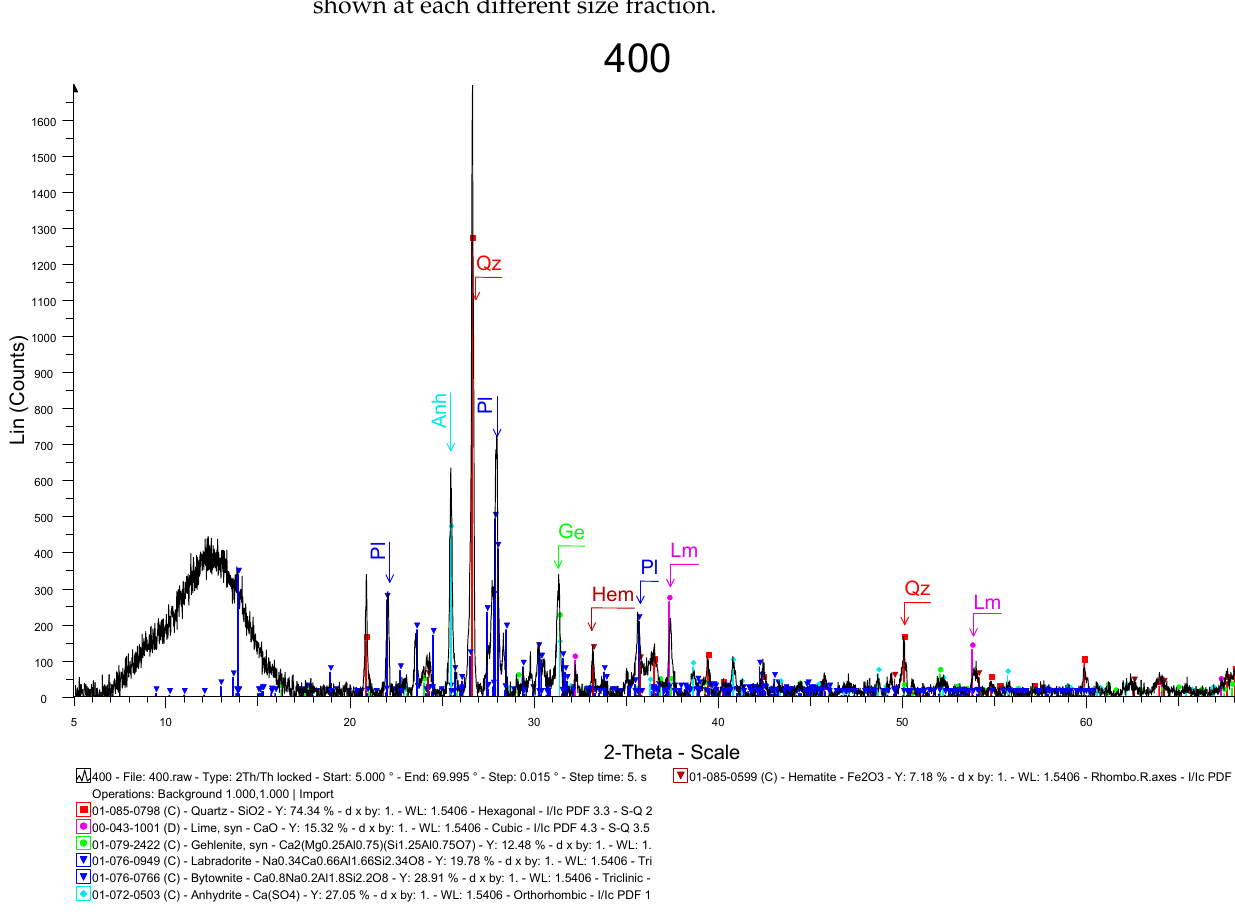
Figure 2. XRD Analysis for the -400 Mesh size fraction. Table 1. Chemical composition of the initial samples and of the various size fractions.